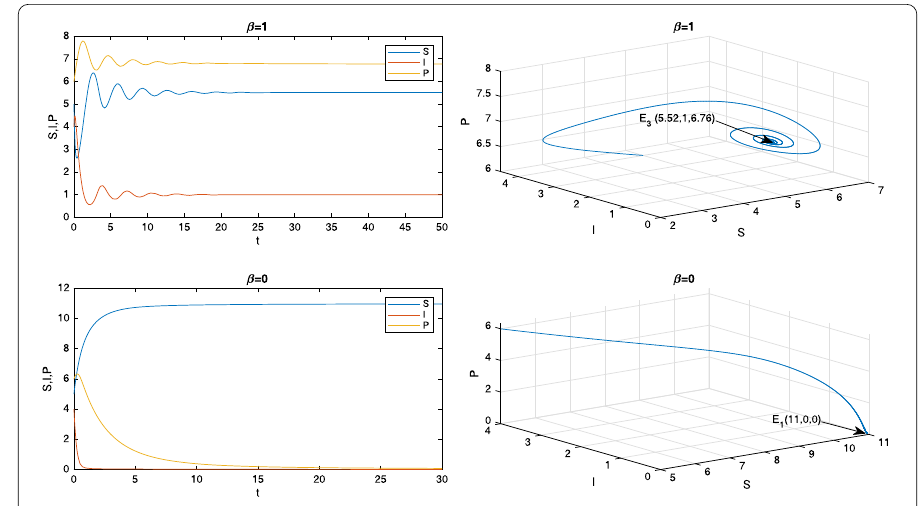
Figure 2 Time series and phase diagram of the stable interior equilibrium point E 3 (5.52,1,6.76) and axial equilibrium point E